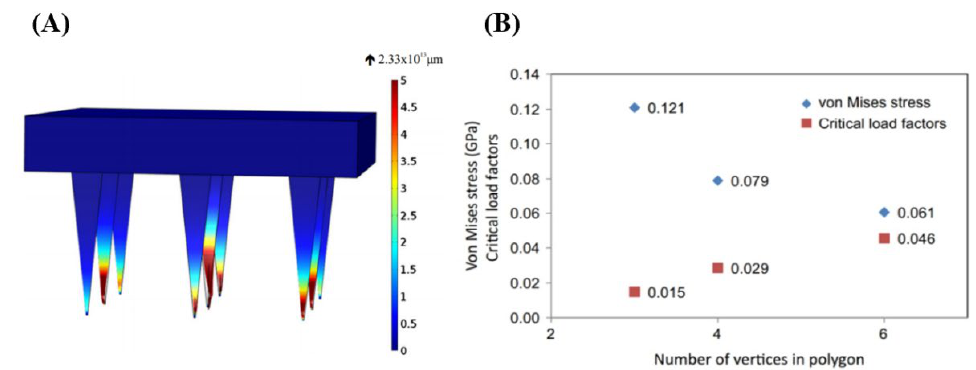
Figure 3. The different types and sizes of microneedle models [54].